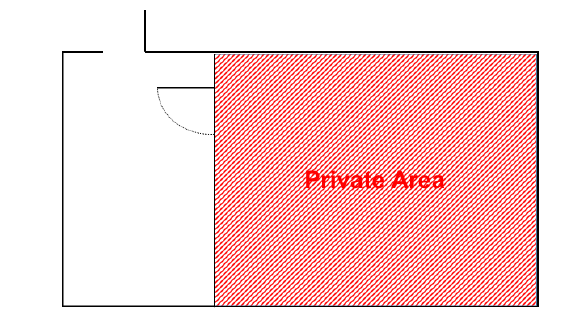
Abstract building plan of the Zollner Elektronik AG Forum’s ground floor at DIT